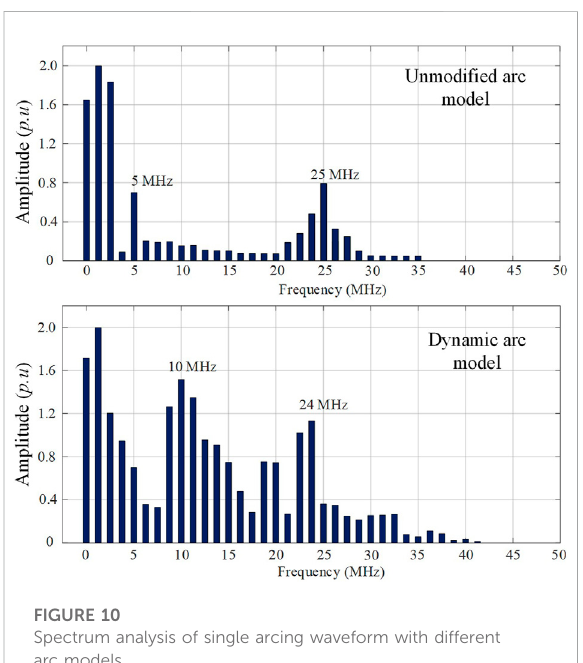
FIGURE 10 Spectrum analysis of single arcing waveform with different arc